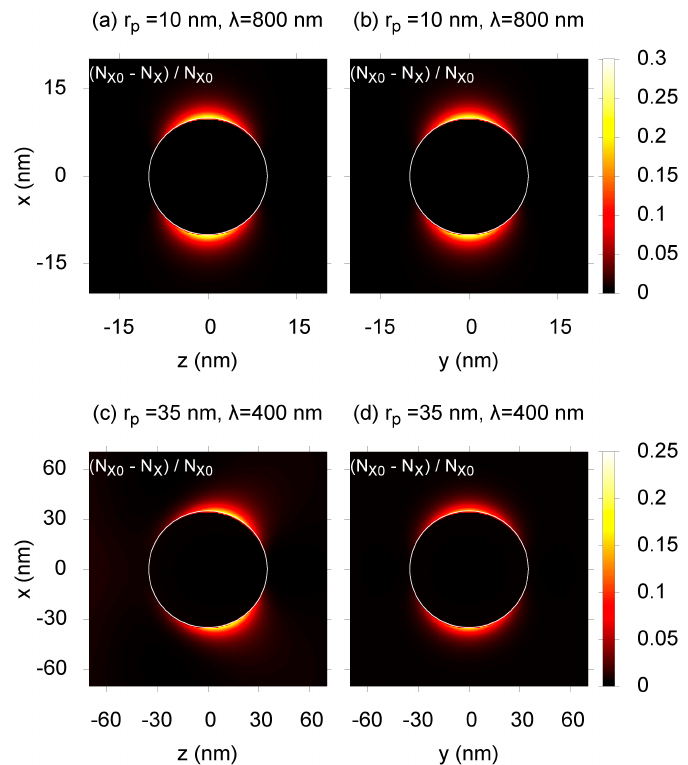
Figure 2. The conversion of species X near the gold nanoparticle (indicated by a white circle) irradiated by N pulse = 10 5 laser pulses of length τ pulse = 100 fs. The two-photon absorption cross-section is σ X (2) = 10 GM (1 GM = 10 −50 cm 4 ·s). The quantum yield is η = 0.8 , and the incident wave is linearly polarized along the x and propagates toward the z direction. For ( a ) and ( b ): r p = 10 nm, λ = 800 nm; the complex refractive index of gold is n p = 0.15 + 4.91 i [15], the refractive index of polymethyl methacrylate (PMMA) is n m = 1.484 [16]; the incident beam intensity is I 0 = 5 × 10 8 W/cm 2 . For ( c ) and ( d ): r p = 35